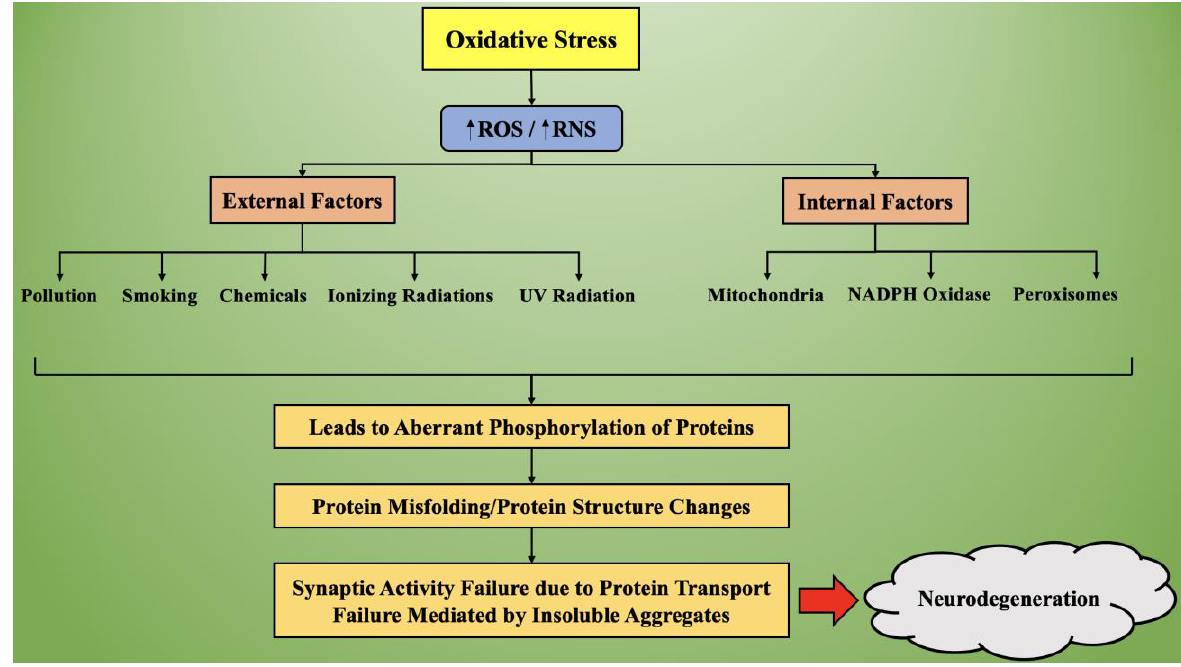
Figure 4. Synthesizing the process of oxidative stress-mediated neurodegeneration. Legend: ROS — reactive oxygen species; RNS — reactive nitrogen species; UV — ultraviolet; NADP — nicotinamide adenine dinucleotide.